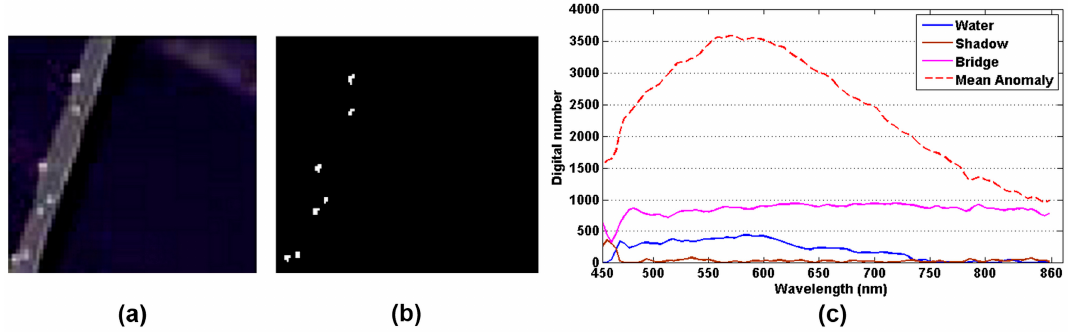
Figure 3. ( a ) The image scene of PaviaC dataset by the ROSIS sensor; ( b ) ground truth map of 47 pixels representing anomalies; and ( c ) spectral curves of background and average anomalous signature.